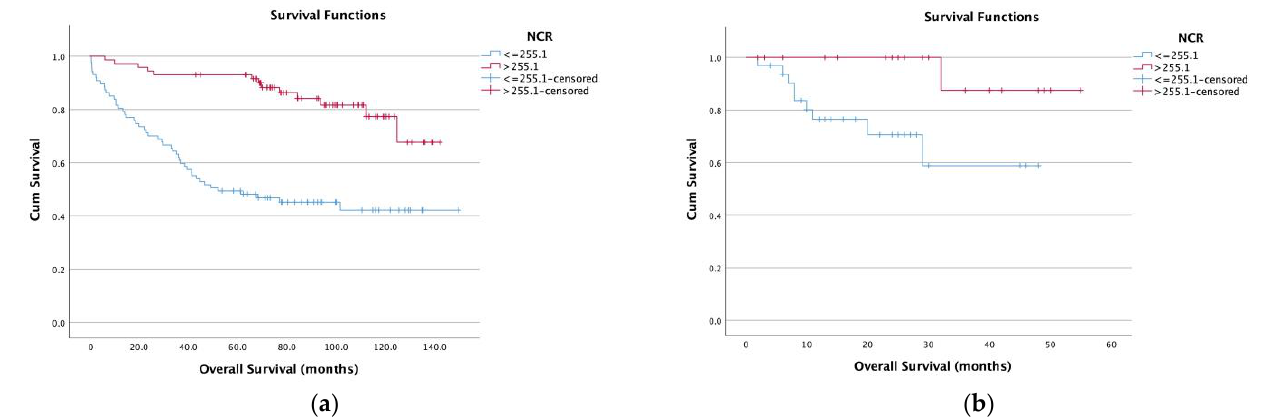
Figure 3. Prognostic effect of the NCR status on the OS of patients with colon cancer in the discovery cohort ( a ) and the validation cohort ( b ).